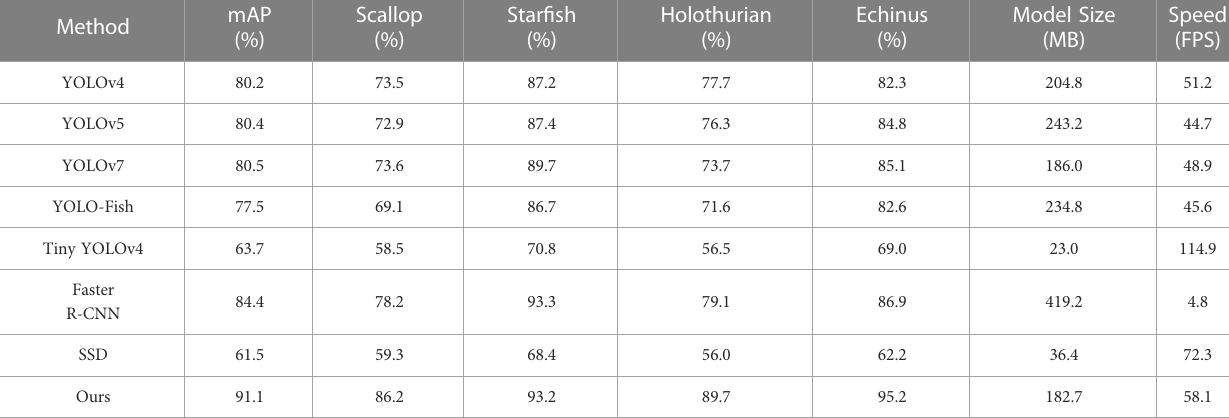
TABLE 3 Experimental results of different algorithms on the URPC